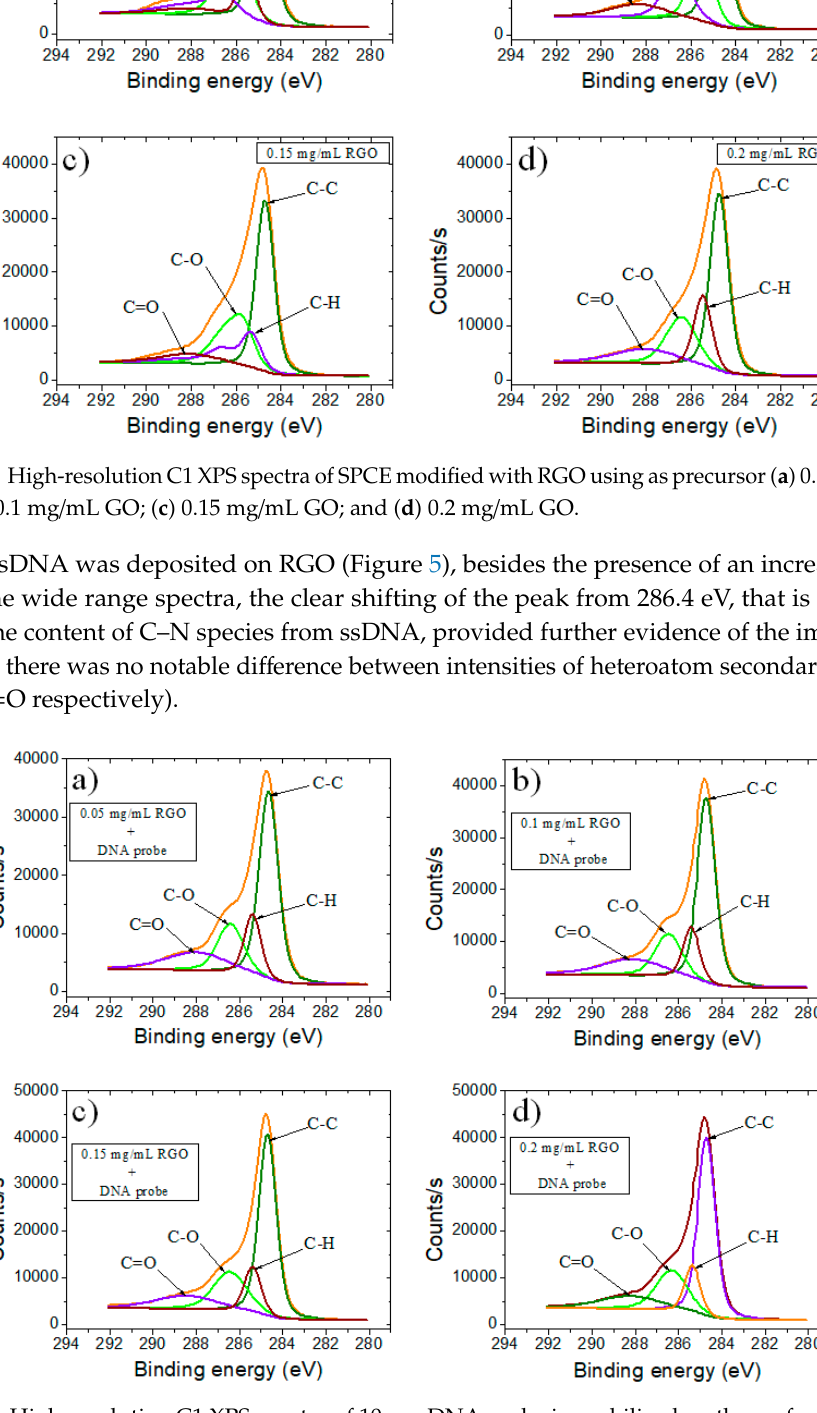
Figure 5. High-resolution C1 XPS spectra of 10 µm DNA probe immobilized on the surface of SPCE modified with RGO using as precursor ( a ) 0.05 mg/mL GO; ( b ) 0.1 mg/mL GO; ( c ) 0.15 mg/mL GO; and ( d ) 0.2 mg/mL GO.